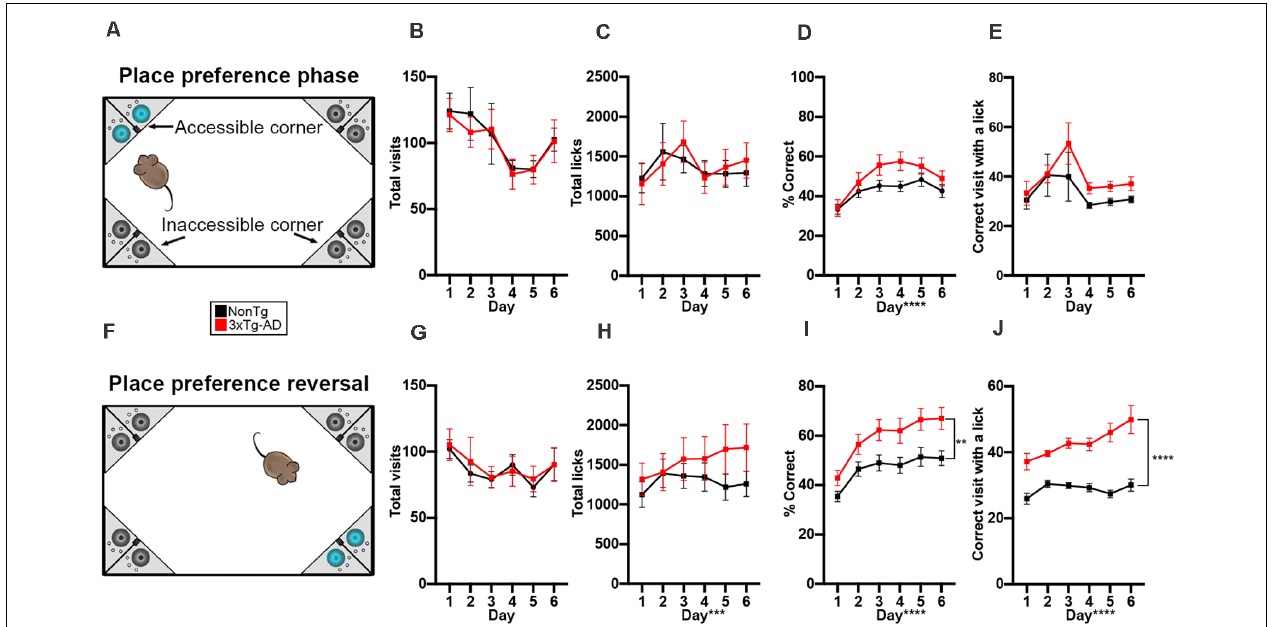
FIGURE 3 | 3xTg-AD mice performed similarly to NonTg mice in learned place preference but later performed better than NonTg mice in the reversal phase of the IntelliCage. (A) During the 6 days of the learned place preference phase, animals were assigned to one corner where they could access water. All other corners were counted as incorrect and allowed no access to water; cage not drawn to scale. (B,C) We found no significant differences in total visits and licks during the place preference phase. (D) We found a significant effect of day for % correct, illustrating learning across the 6 days, but no genotype differences were detected. (E) No differences were detected in the correct visits with ≥ 1 lick. (F) During the 6 days of the place preference reversal phase, animals could access water by entering and nosepoking the opposite corner from the corner assigned during the learned place preference phase; cage not drawn to scale. (G) No differences in total visits across the 6 days were detected. (H) We found that total licks increased across the 6 days ( p < 0.001). (I) We found that 3xTg-AD had a higher % correct than NonTg ( p < 0.01). Additionally, % correct increased across the 6 days ( p < 0.0001), illustrating learning. (J) We found that 3xTg-AD mice made more visits to the correct corner with ≥ 1 lick than NonTg mice, illustrating that 3xTg-AD mice were motivated to enter the correct corner to drink. Additionally, correct corner visits with ≥ 1 lick increased across the 6 days ( p < 0.0001). Data are presented as means ± SEM. ** p < 0.01, *** p < 0.001, **** p <